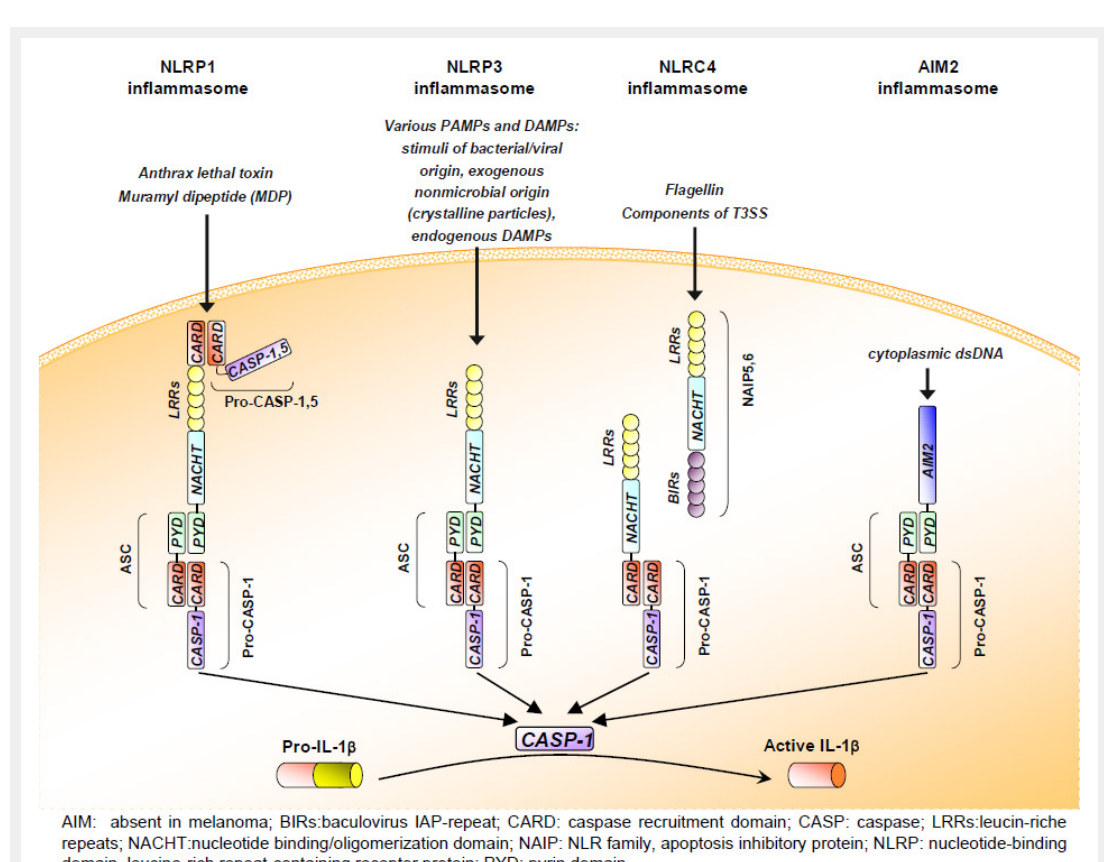
Figure 1 The inflammasomes. Several types of inflammasomes have been described. Upon exposure to specific PAMPs/DAMPs, respective inflammasomes are activated, leading to the proteolytic cleavage of caspase-1 or -5 (CASP) and subsequent cleavage of pro-IL1β into its active, secreted